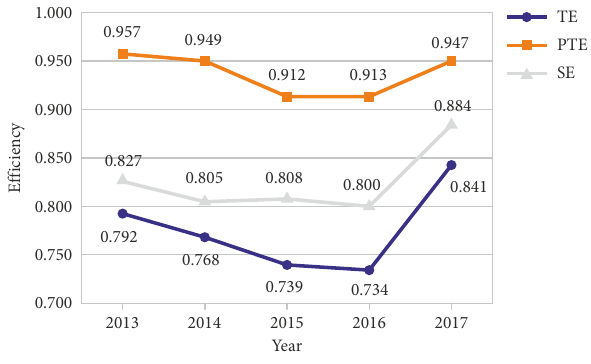
Figure 4. Average efficiencies of 20 airports from 2013 to 2017 in the third stage